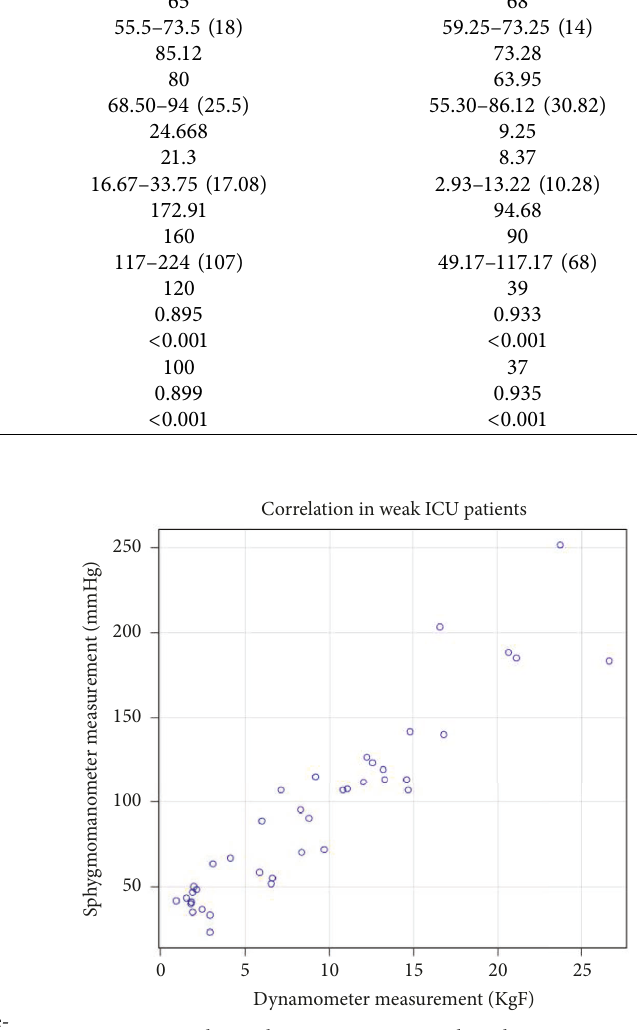
Figure 3: Correlation between grip strength techniques in weak ICU